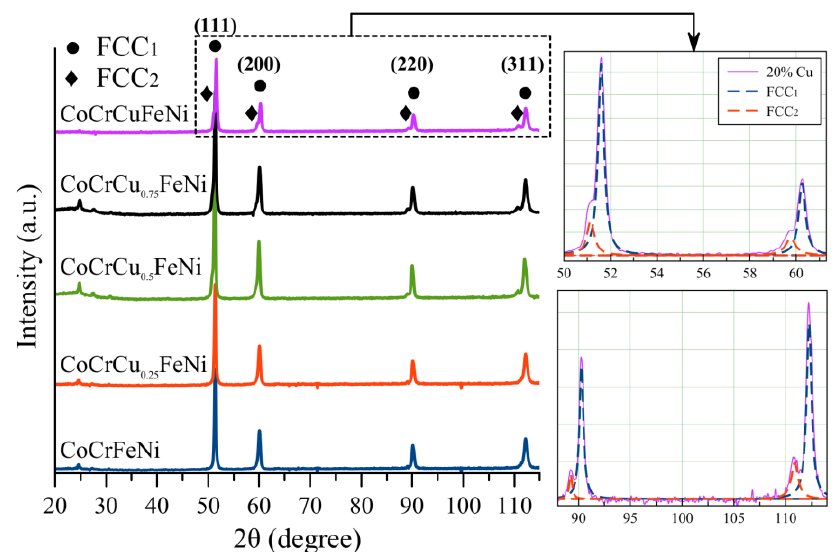
Figure 4. XRD patterns of the CoCrCu x FeNi compact samples.